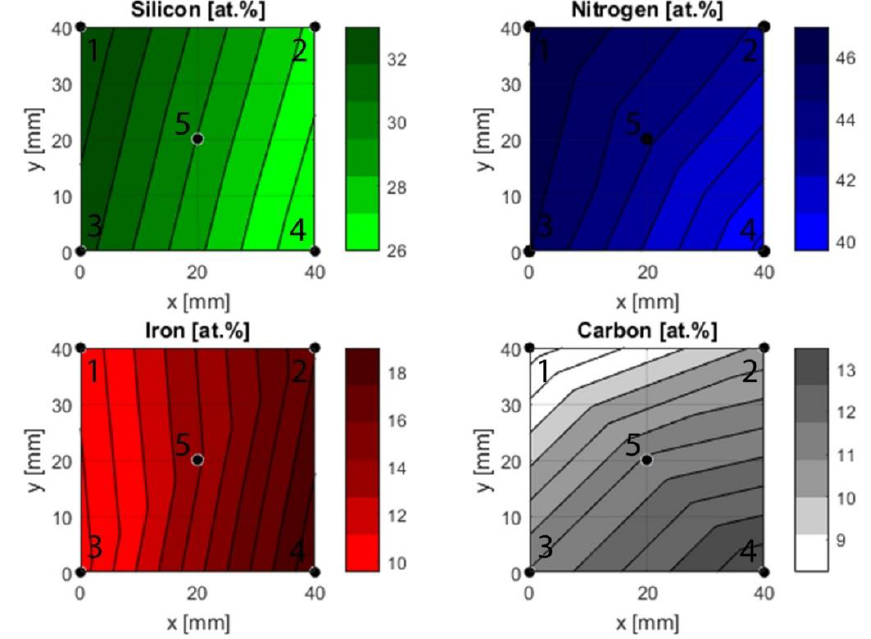
Figure 3. Compositional gradients based on ToF-ERDA measurements. The fit is created using a piecewise linear interpolation that fits a linear polynomial between sets of three points, e.g., 1, 3 and 5.